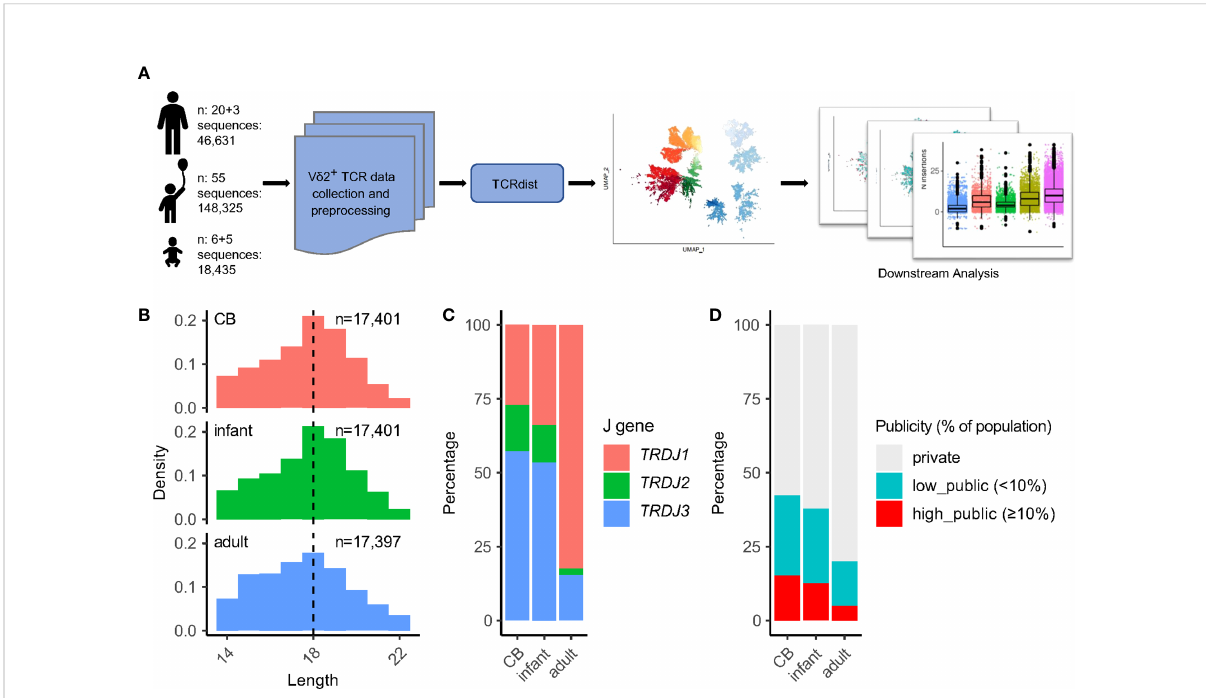
FIGURE 1 Experimental design and data pre-processing. (A) Illustration of the data analysis work fl ow. Our datasets were collected from 11 CB, 55 infants, 23 adults; among them, datasets from fi ve CB and three adults were unpublished data. (B) Sequence length distribution of 52,199 CDR3aa sequences from CB, infant, and adult groups after down-sampling and pre-processing. The numbers indicate the number of CDR3aa sequences after down- sampling. Dashed lines indicate the median value of CDR3 length. (C) J gene usage among different age groups. (D) CDR3aa publicity composition among age groups. The publicity of a CDR3aa sequence is de fi ned by the proportion of individuals that share this